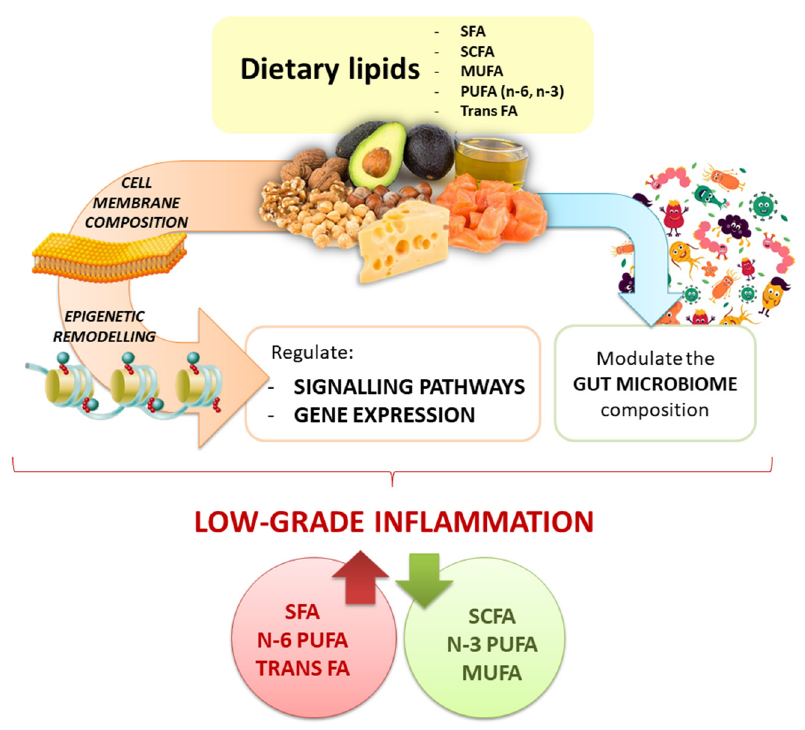
Figure 3. Graphical overview of the nutrigenomic impact of dietary lipids.